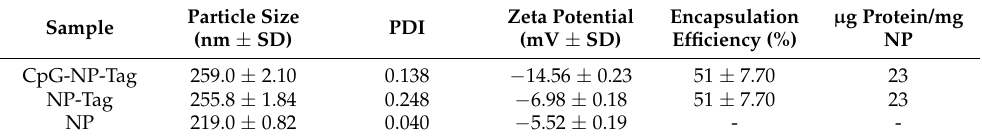
Table 1. Physicochemical characterizations of NP